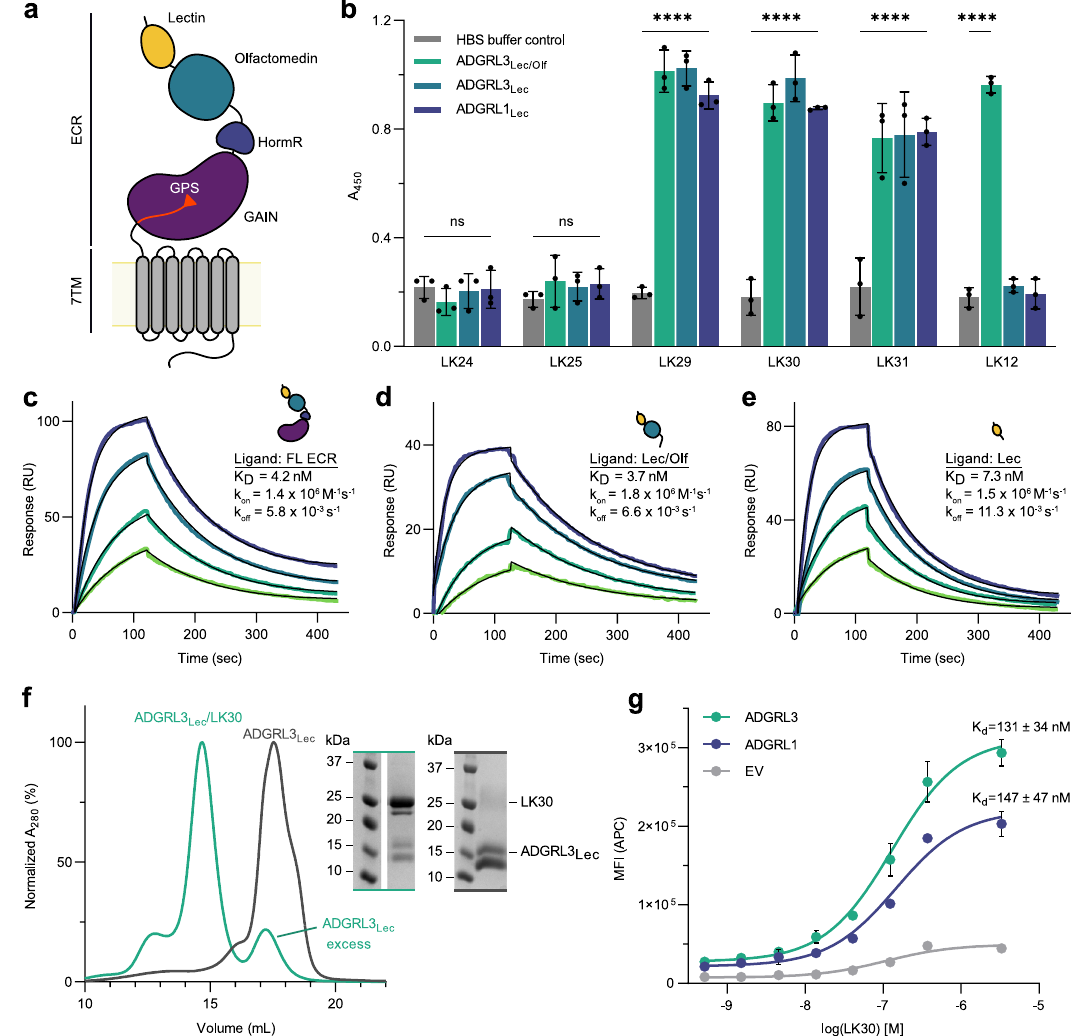
Fig. 1 | Characterization of the sABs against ADGRL3. a Schematic diagram of full-length human ADGRL3. The Lectin domain is colored yellow, Olfactomedin - cyan, Hormone Binding Region - navy, GAIN - purple and 7TM - gray. The last β - strand of the GAIN domain is colored red and the autoproteolysis site within the GAINdomain(GPS)ispresentedasatriangle. b Representativesingle-pointprotein ELISA of the antibody binders obtained from phage display. Epitope mapping shows that sABs LK29-31 bind to the lectin domain of both ADGRL3 and ADGRL1. Data are presented as mean±SDof three repeats ( n =3), ns p =0.9988; ns p =0.6364; **** p <0.0001vs.HBSbuffertreatment;two-wayANOVA.Sourcedataareprovided as a Source Data fi le. c – e Surface plasmon resonance measurements of the LK30 bindingto( c )puri fi edADGRL3ECR,( d )Lec/Olffragment,and( e )Lecdomain.Each sAB concentration is shown in a different color trace. Within each plot, the